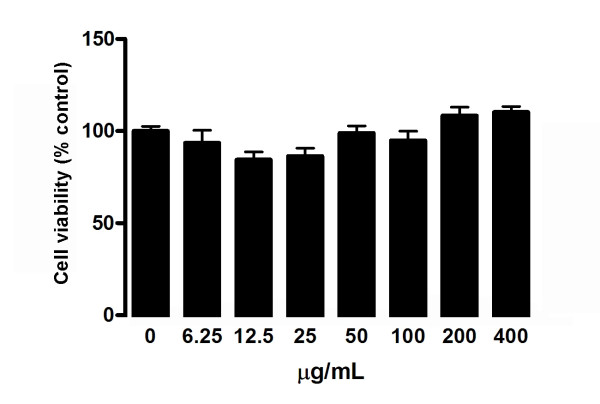
Effect of FLL aqueous extract on the cell viability of P2 undifferentiated rat MSCs. MSCs were treated with different concentrations of FLL extract for two days. The cell viability was estimated by MTT assay and the results are expressed as mean ± SD of three independent experiments each in triplicates.